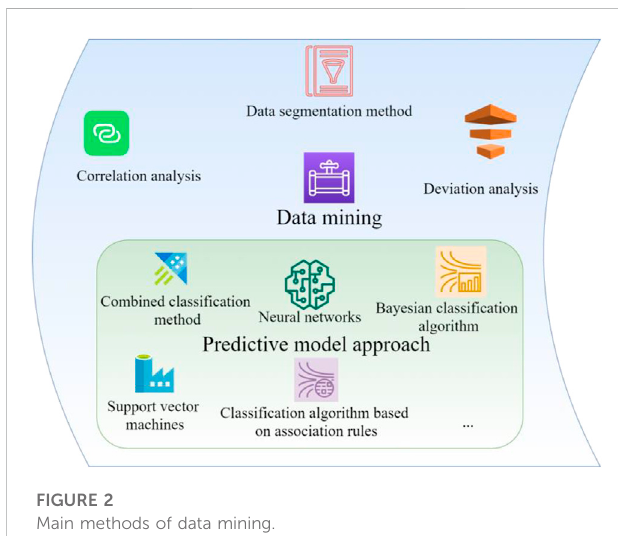
FIGURE 2 Main methods of data